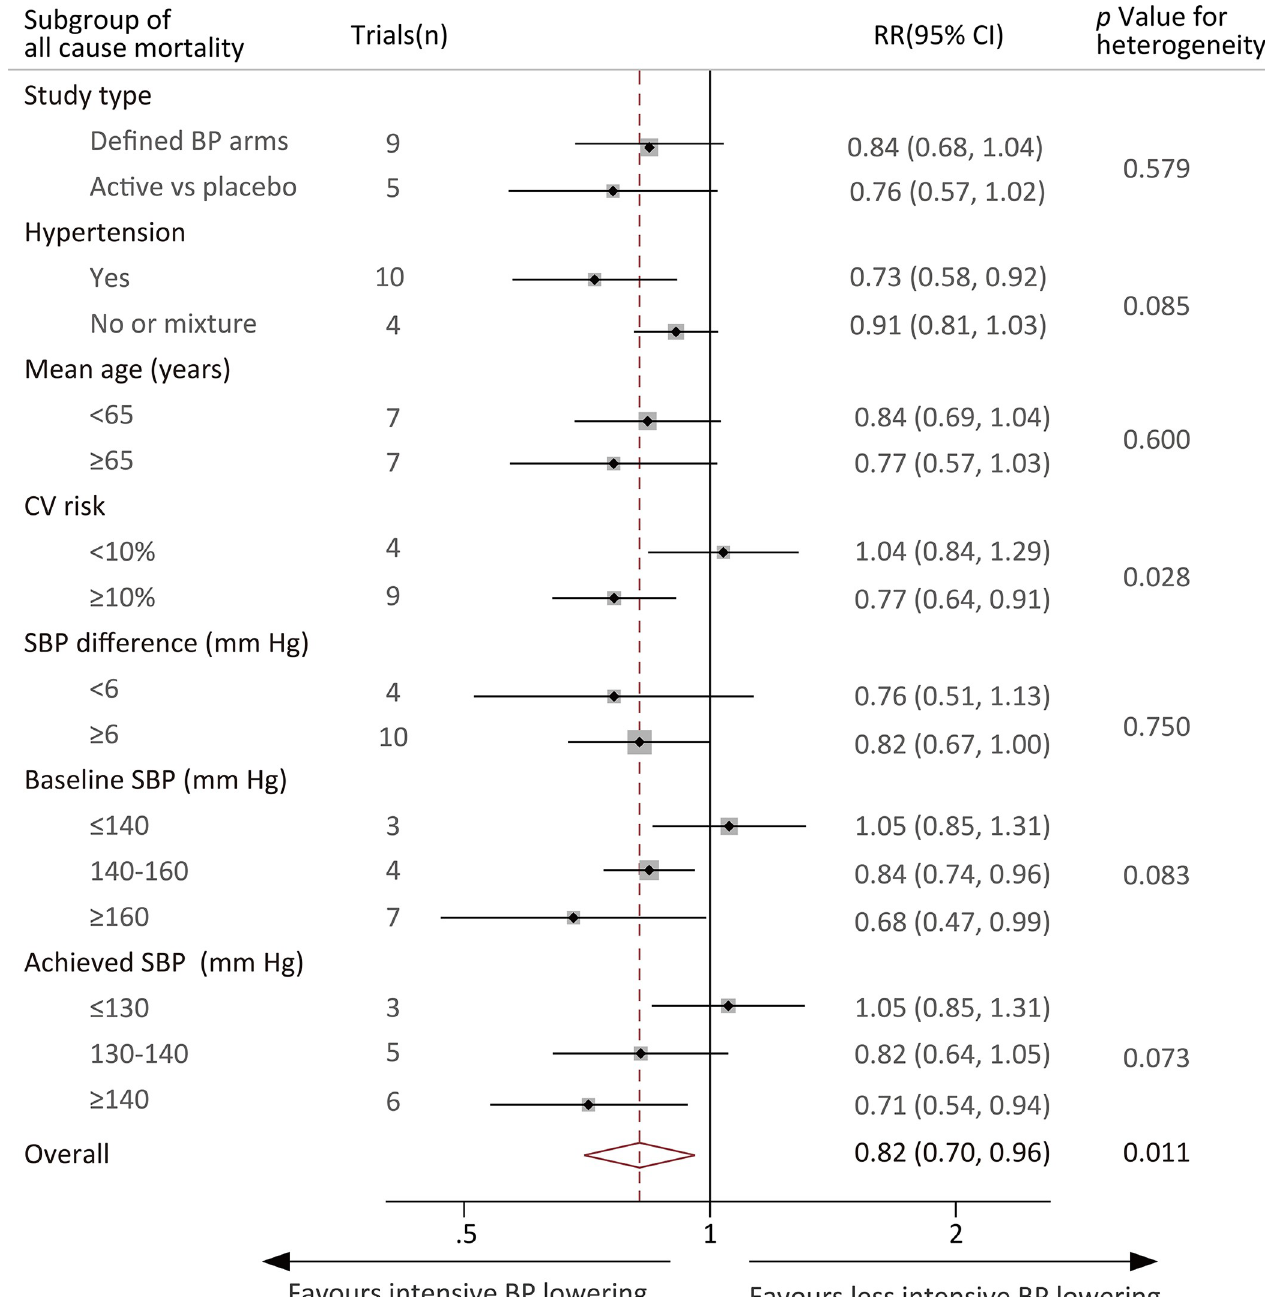
Fig 6. Effect of intensive blood pressure lowering on the risk of all-cause mortality in subgroups of trials.